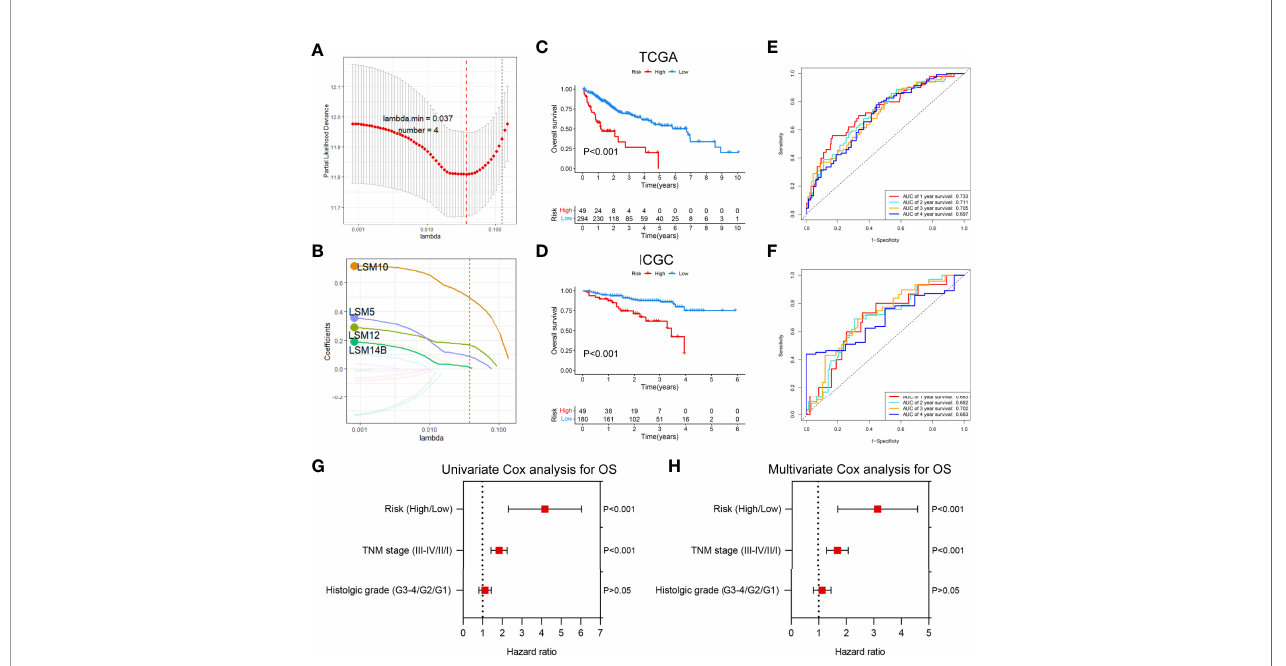
FIGURE 5 | Development and validation of a risk score system for OS based on LSM family members. (A, B) Lasso regression analysis identi fi ed fi ve critical prognosis-associated LSM family members (e.g., LSM5, LSM10, LSM12, and LSM14B) for HCC. (C, D) KM survival curves for OS of patients with HCC according to the risk scores in the TCGA HCC and ICGC HCC cohorts. (E, F) ROC curve analysis of the risk score system for 1-, 2-, 3-, and 4-year OS prediction in the TCGA HCC and ICGC HCC cohorts. (G) Univariate Cox regression analysis demonstrated that the risk score system and TNM stage were prognostic factor for OS of patients with HCC. (H) Multivariate Cox regression analysis demonstrated that the risk score system was an independent unfavorable prognostic factor for OS of patients with HCC. OS, overall survival; LSM, Smith-like (LSM) family members; Lasso, least absolute shrinkage and selection operator regression analysis; HCC, hepatocellular carcinoma; KM, Kaplan – Meier; TCGA, the Cancer Genome Atlas; ICGC, the International Cancer Genome Consortium; ROC, the receiver operating characteristic curve.